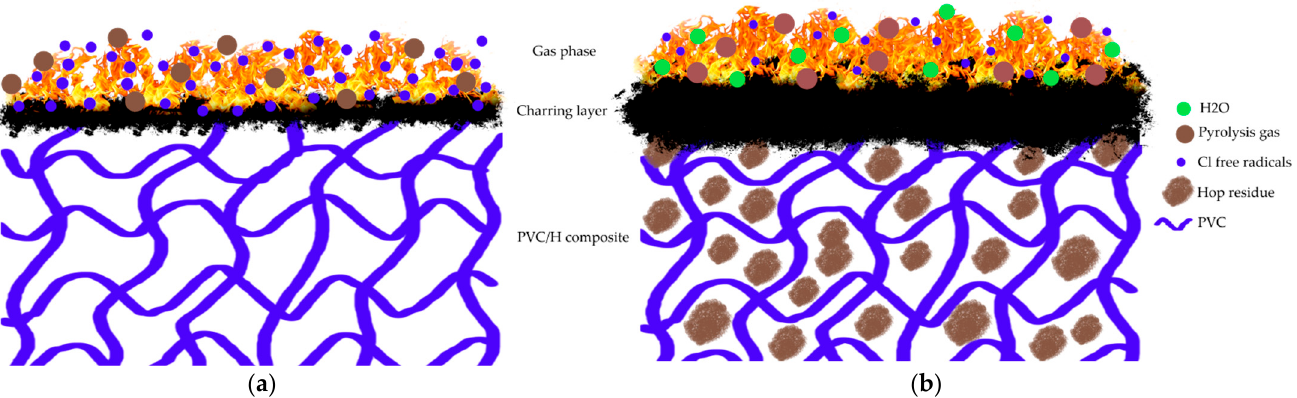
Figure 12. An illustration of the possible mode of flame retardant action in PVC ( a ) and PVC/H composites ( b ).